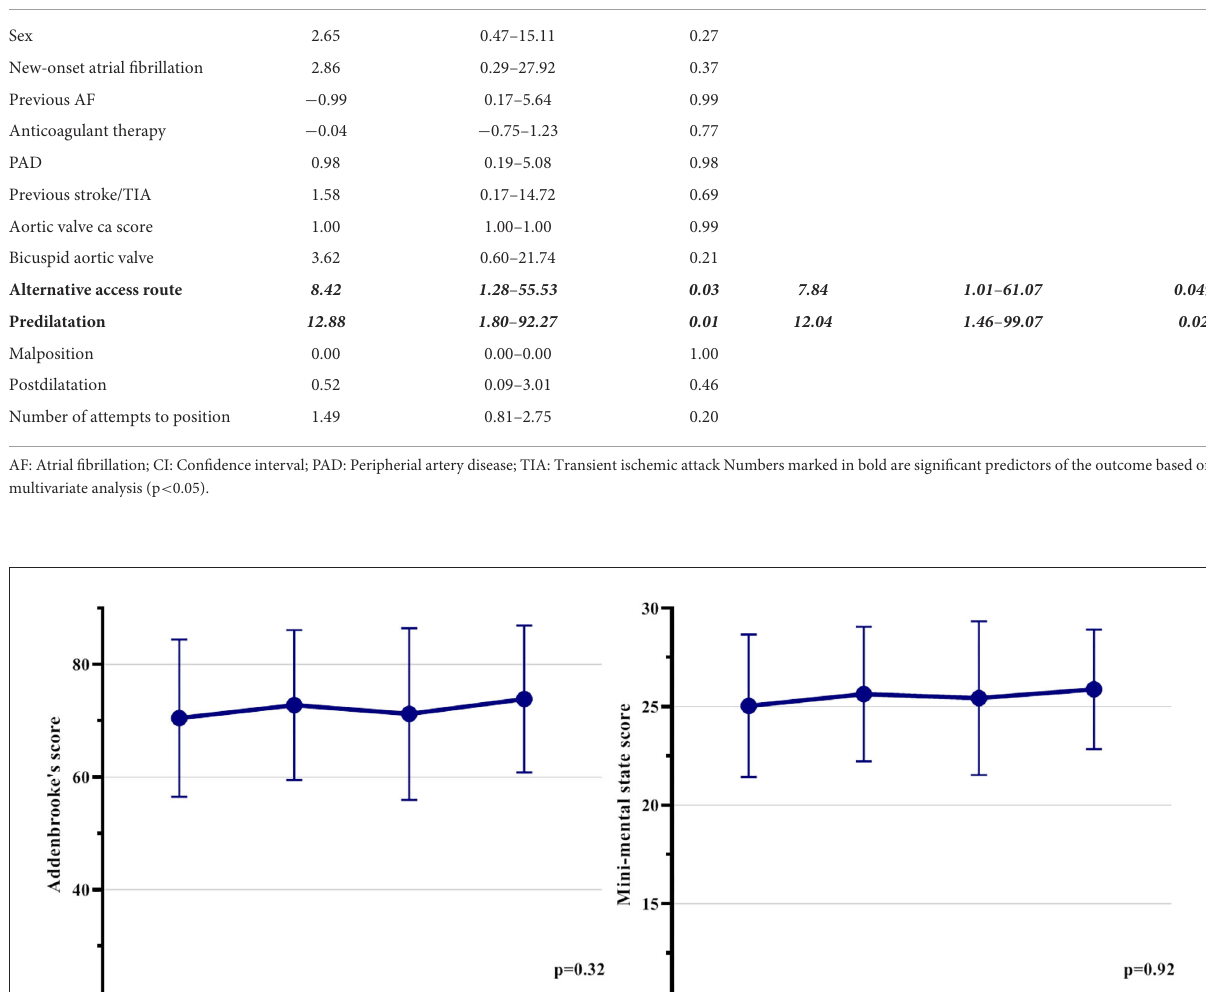
recent meta-analysis showed that diabetes, kidney disease, and predilatation increased the overall risk for SCIL